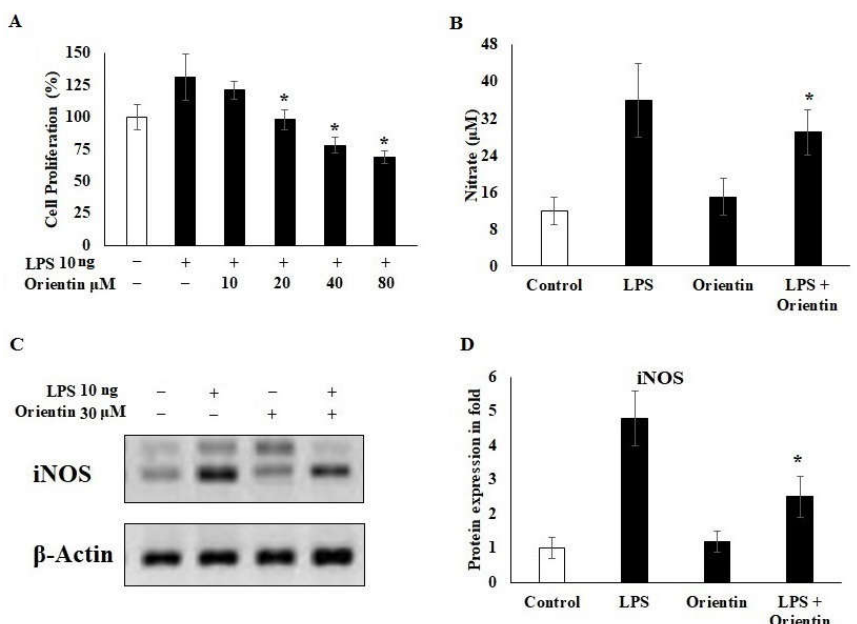
Figure 5. Effect of orientin on LPS-induced inflammatory HSCs. Naïve mouse-derived HSCs were isolated and cultured in an adherent-coated 12-well plate. Cultured cells were stimulated with LPS 10 ng for 2 h and orientin was treated for 12 h. Treated cells were evaluated for cell proliferation, nitrate quantification, and iNOS protein. ( A ) Cell proliferation of LPS-stimulated HSCs and LPS with orientin-treated cells were quantified using SRB assay. ( B ) Nitric oxide level as nitrate (μM) in LPS-stimulated and orientin-treated HSCs. ( C , D ) iNOS protein quantification using immunoblot. Values are expressed as three independent experiments and all values are expressed as mean ± SD. * Represents the significant comparison with control and LPS-induced groups.